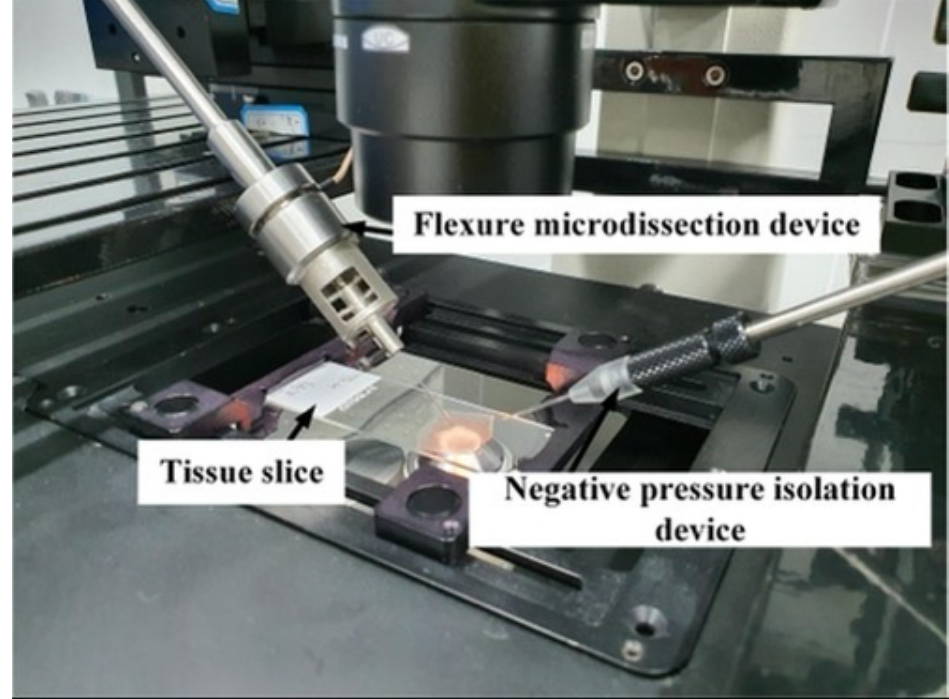
Figure 9. Experimental platform for tissue section dissection .